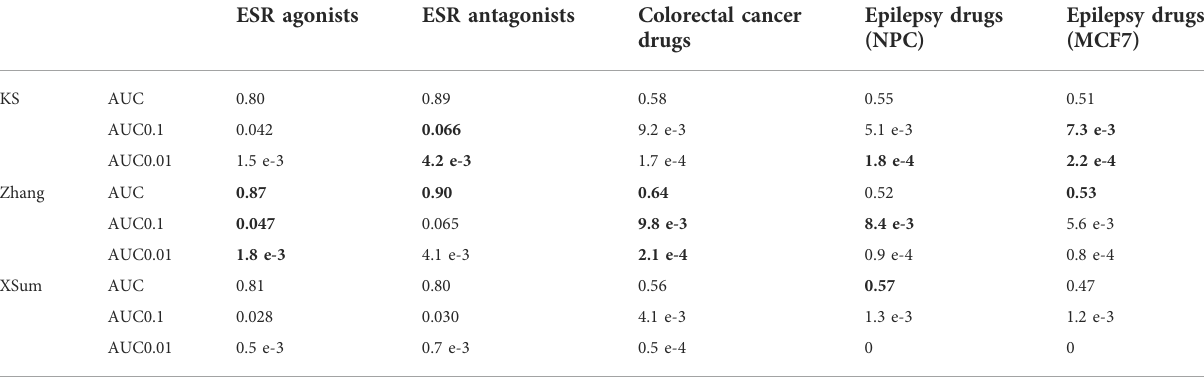
TABLE 5 AUC of each method in the analysis of 17b-estradiol, colorectal cancer and epilepsy